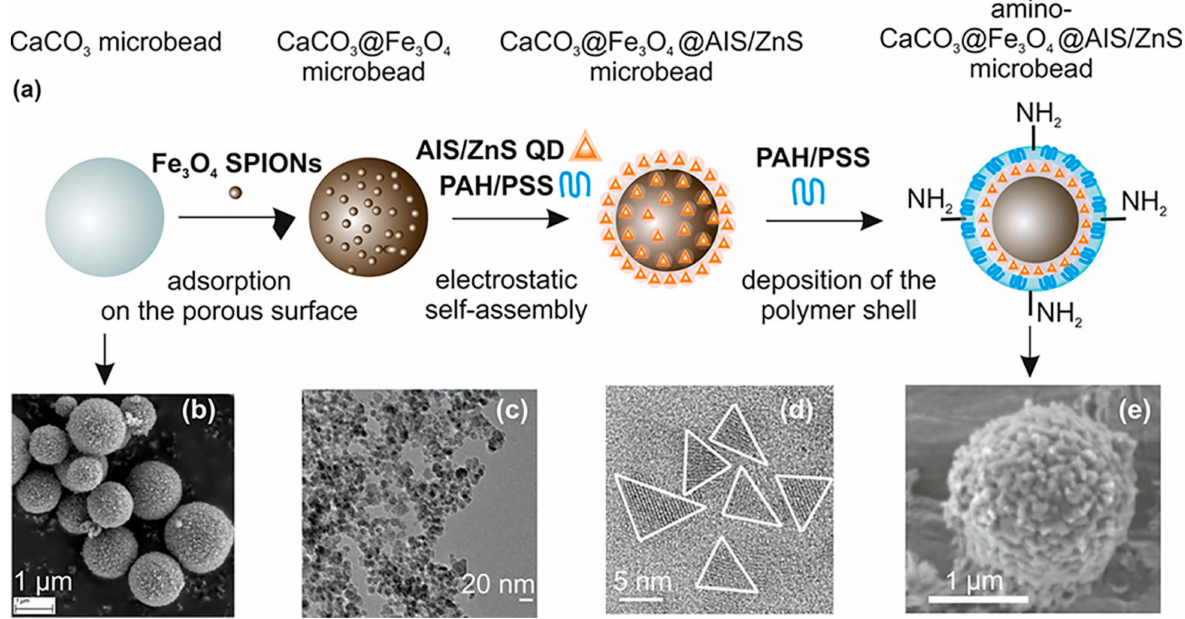
Figure 10. ( a ) Illustration of multistep synthesis of aminated magneto-fluorescent CaCO 3 microbeads and ( b – e ) SEM and TEM pictures of building blocks: ( b ) CaCO 3 spherical microparticles, ( c ) Fe 3 O 4 SPIONs capped with PSS, ( d ) AIS/ZnS QDs stabilized with MPA, and ( e ) CaCO 3 @Fe 3 O 4 @AIS/ZnS microbeads containing amino surface groups for further bioconjugation